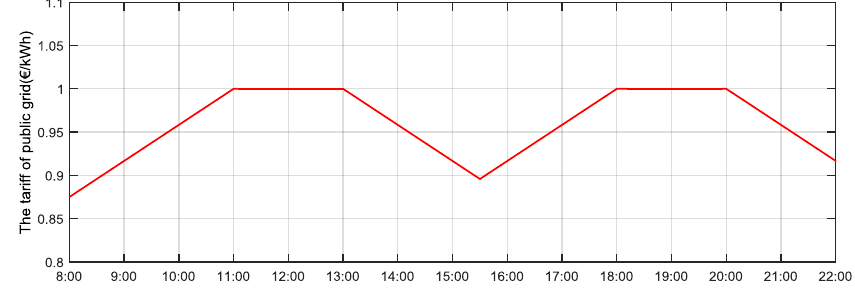
Figure 7. Energy tariff of the public grid.